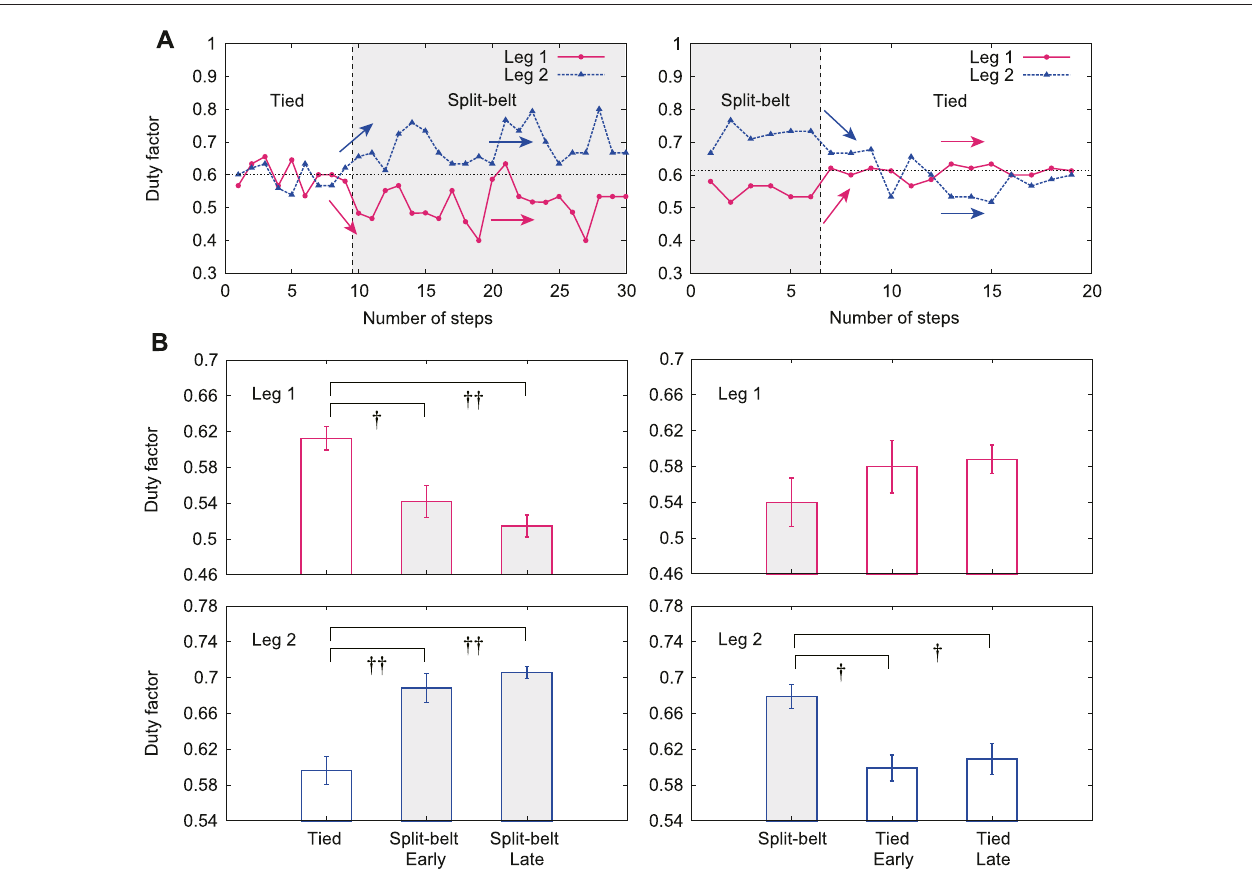
FIGURE8 | Duty factors for Legs1 and 2with use ofboth spinal and cerebellarmodels. (A) Onerepresentative trial. (B) Averagesfor each period.Datapoints and error bars are the mean and standard error results of fi ve experiments, respectively. † : p < 0 . 05 and †† : p < 0 . 01.